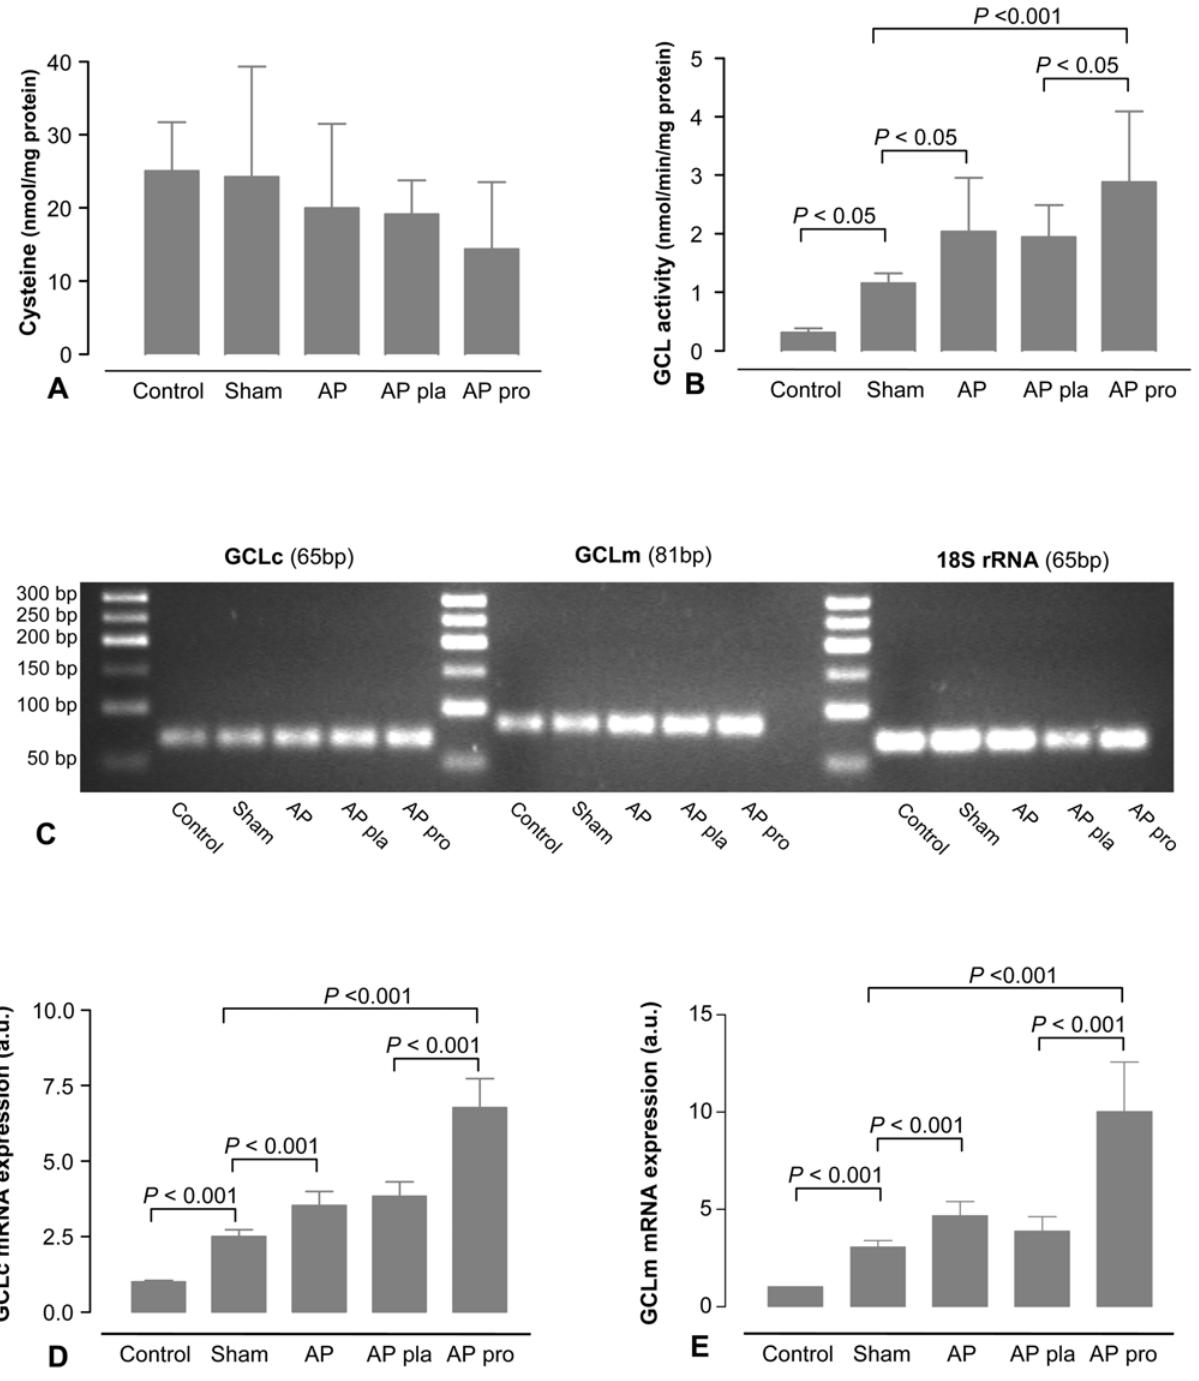
Figure 7. Probiotics have no effect on cysteine availability, but induce glutamate-cysteine-ligase activity. After 5 days of pre-treatment with placebo (pla, n=12) or probiotics (pro, n=12), rats were subjected to acute pancreatitis (AP, n=12), a sham-procedure (n=12) or not operated (control, n=5). Six hours after induction of the AP or sham-procedure, tissue cysteine availability (A) and mucosal glutamate-cysteine-ligase (GCL) activity (B) were determined in ileum samples. (C) RT-PCR was conducted on ileal mRNA. PCR products of specific primers for the catalytic (GCLc, 65 bp) and the modulatory (GCLm, 81 bp) subunit of GCL and for 18S rRNA (65 bp) as control were identified on 2.5% agarose gel, using a GeneRuler 50 bp DNA Ladder (Fermentas GMBH, St. Leon-Rot, Germany). mRNA expression of (D) GCLc and (E) GCLm were quantified. Data are normalized to 18S rRNA expression and expressed as ratio to control animals. The graphs show average ( 6 SD). All analyses were run in triplicates. Comparisons were performed using ANOVA followed by Tukey’s HSD.